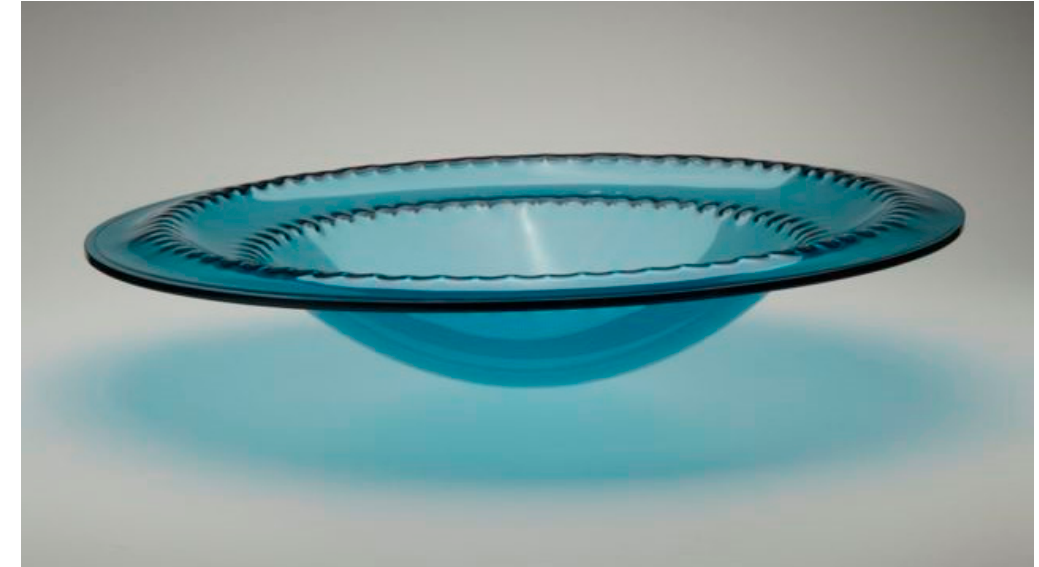
Figure 12. Blue Orbit Bowl (by the author, part of the second stage of the creative explorations with the glass RPT system, (photo: Jorgensen, T. 2013).